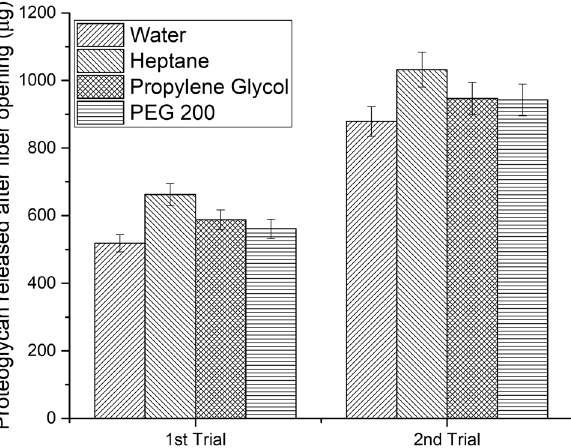
Figure 9. Proteoglycan release after fiber opening during recycling of solvent-enzyme